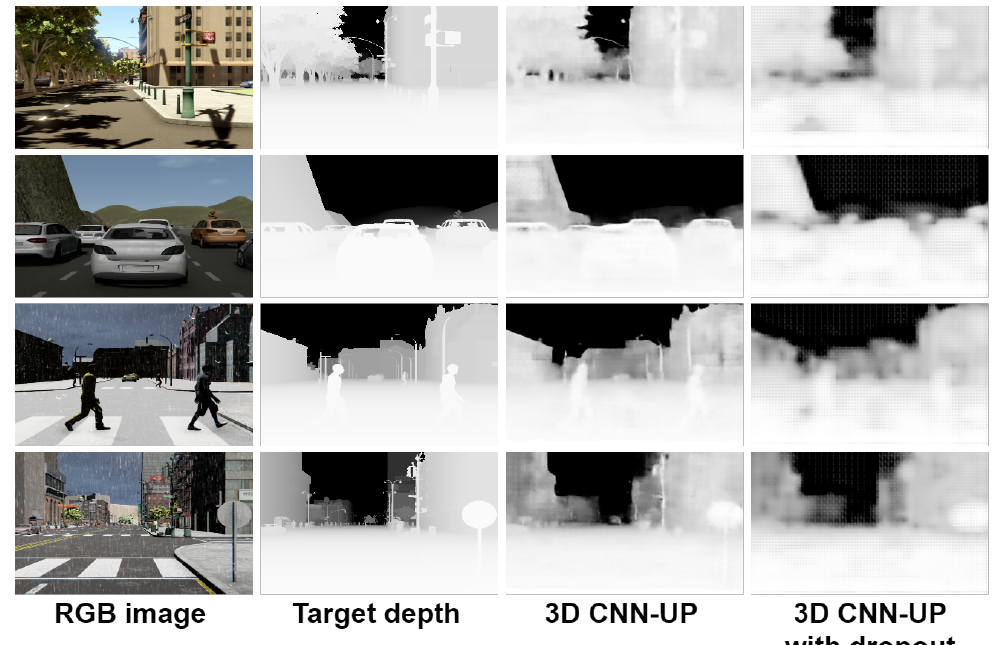
Figure 15. Results obtained with the 3D CNN-UP model. The best results were obtained using the 3D CNN-UP model without dropout, being better than those obtained using the 3D CNN-UP with dropout. In Figures 16 and 17, the same results are shown after a histogram equalization, to improve contrast and allow better visualization.